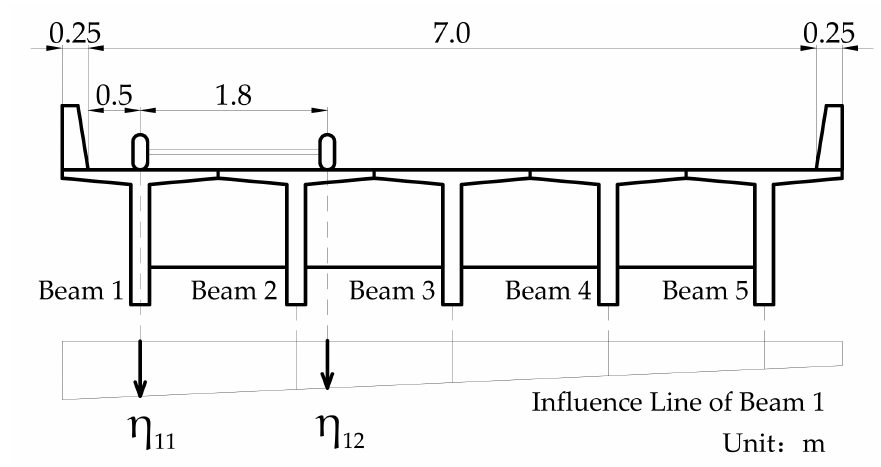
Figure 1. The most unfavorable position and LLD influence line of Beam